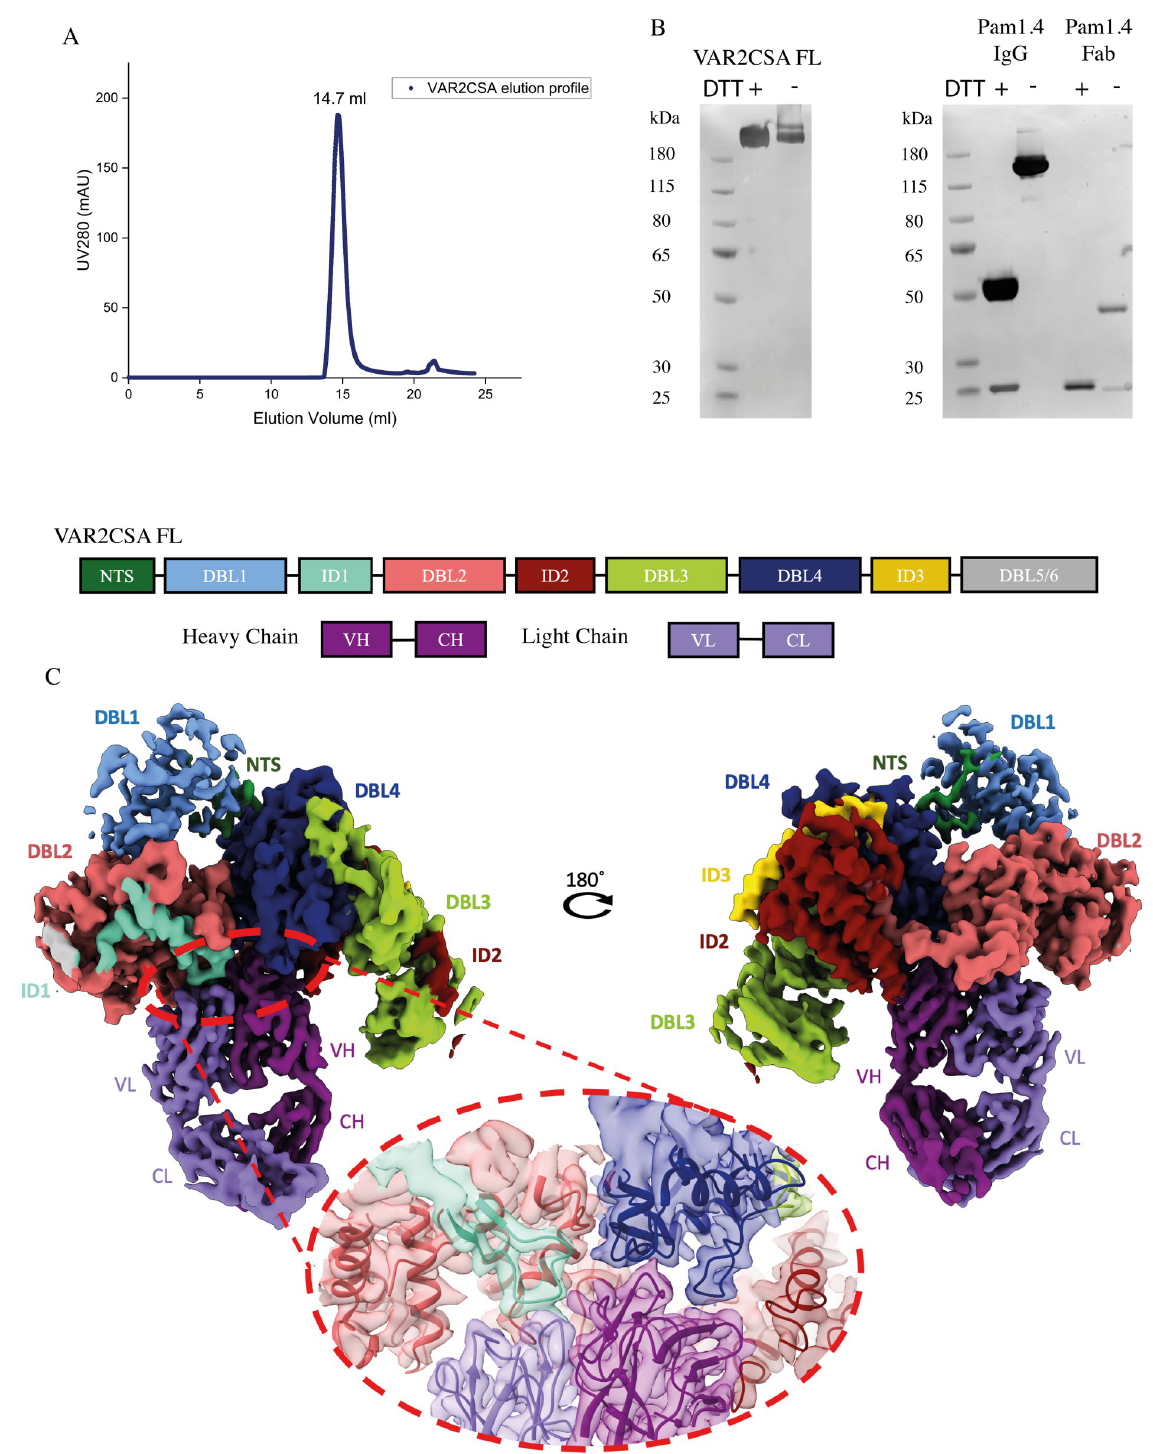
Fig 2. CryoEM reveals conformational epitope binding of PAM1.4 Fab to VAR2CSA. (a). Gel filtration profile of VAR2CSA full length in 20mM Tris HCl, 150mM KCl, pH. 7.5 buffer. (b) Silver stained SDS-PAGE reduced/ non-reduced of full-length VAR2CSA (307 kDa), PAM1.4 IgG and PAM1.4 Fab after IgG digestion and Fc removal by reverse protein A purification. (c) Overall architecture of VAR2CSA with PAM1.4 Fab, flipped 180˚. The domains are colored individually. NTS–N-terminal Sequence, DBL- Duffy Binding Like domain, ID- Inter- domain, VH, CH–Variable and Constant Heavy, VL, CL–Variable and Constant Light. The binding region is magnified and highlighted with 50% transparency to show conformational epitope binding.